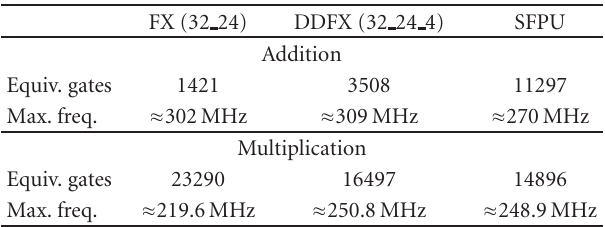
Figure 6: Measurement of average current drawn from VCCINT, VCCAUX, and VCCO.